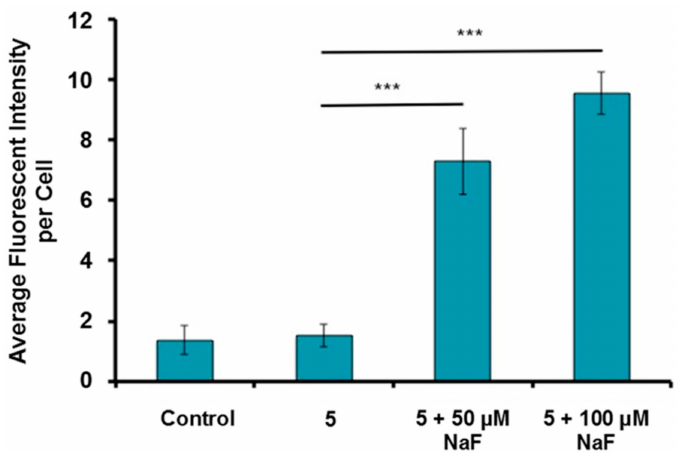
Figure 11. Average fluorescent intensity per cell from each group of the cell imaging study (average values and error bars are acquired from 3 images of each imaging condition). Statistical analysis was calculated by student’s t -test (*** p < 0.001).